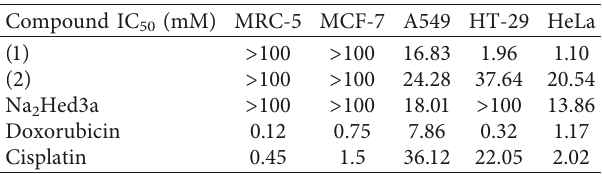
Figure 13: Molecular structures of (pentamethylcyclopentadienato) Rh(III) complexes. (a) [Rh( ∗ Cp)Cl( μ 2 –Cl)] Table 3: Cytostatic activities of Rh(III) coordination compounds and ed3a3 ligand against tumour strains in μ